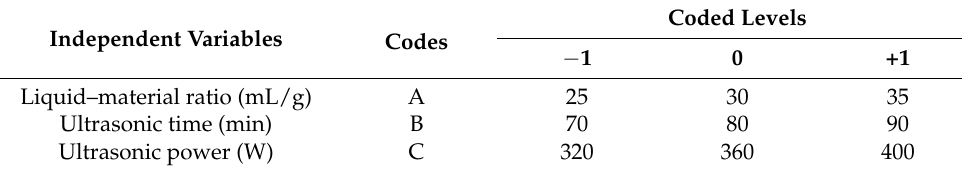
Table 1. Levels and independent variables in BBD matrix.